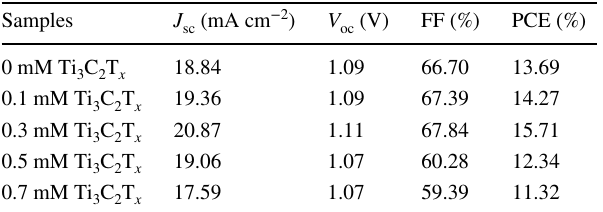
Table 1 Photovoltaic parameters of 2D PSCs with/without Ti 3 C 2 T x additive